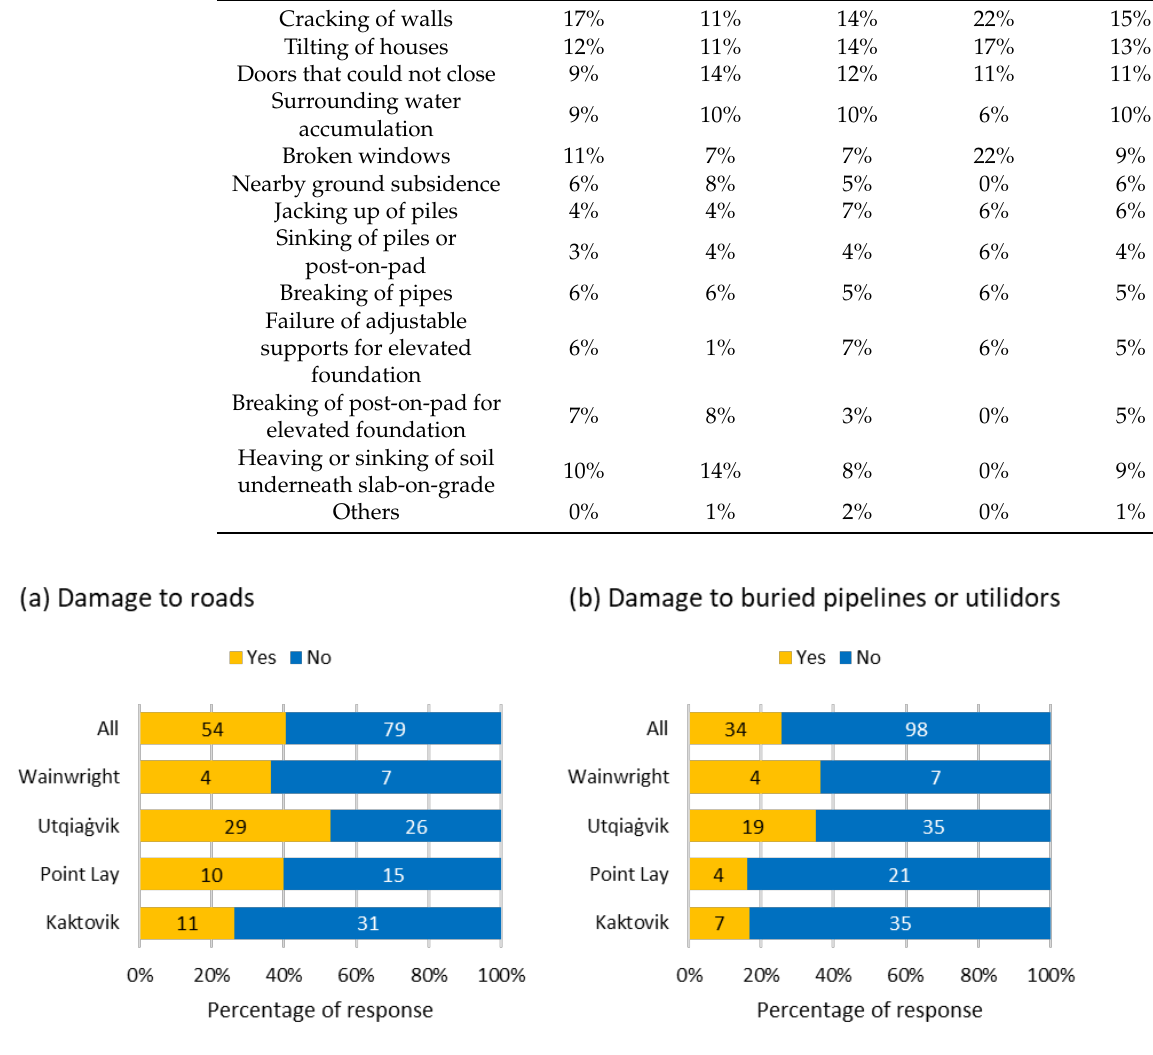
Figure 9. Observations of damage to ( a ) roads and ( b ) buried pipelines or utilidors caused by permafrost thawing.